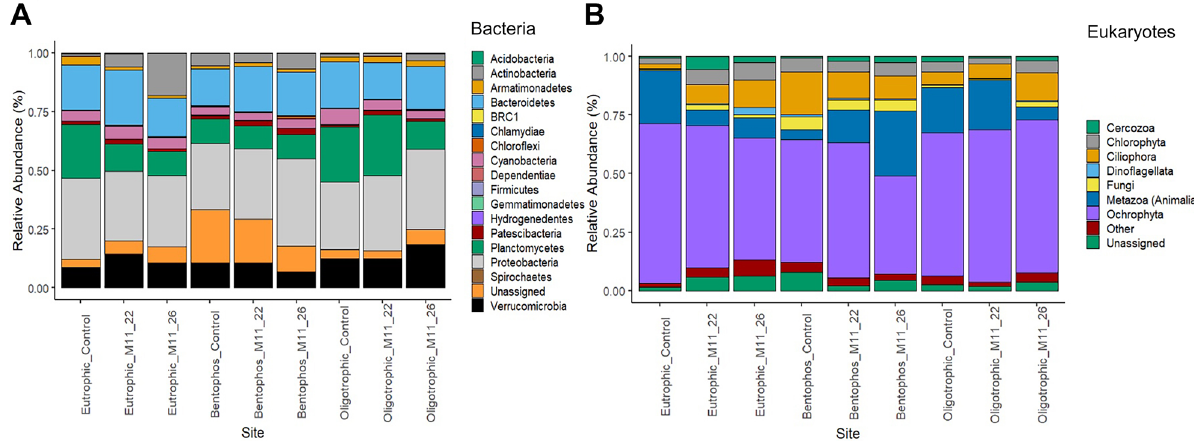
Figure 4. DNA Metabarcoding results to the ( A ) phylum level of the 16S gene for prokaryotes and ( B ) order level of the 18S gene for eukaryotes collected at the end of the four-week experiment. The other category is all orders with < 1% total